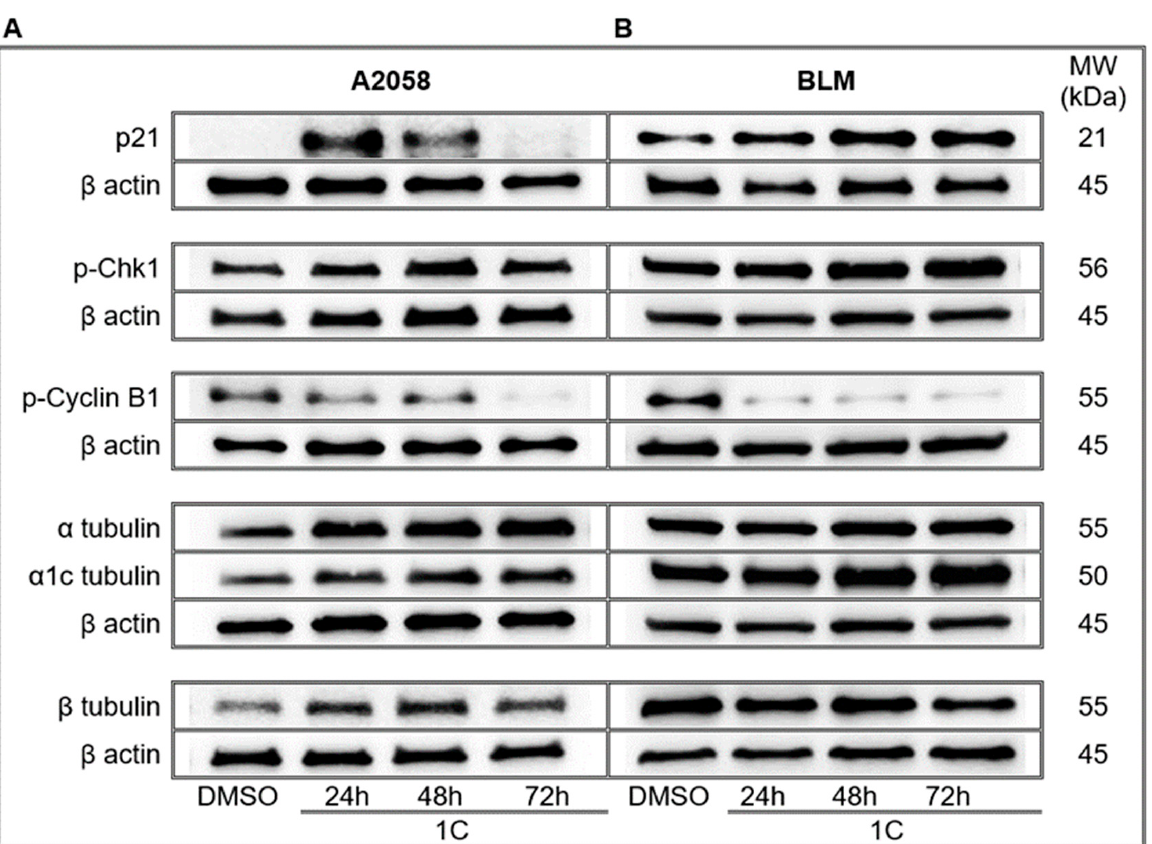
Figure 5. WB analysis of p53 protein in A2058 ( A ) and BLM ( B ) melanoma cells after 24, 48 and 72 h of treatment with chalcone 1C at concentrations of 10 μ mol/L (A2058) and 20 μ mol/L (BLM). Representative WB.